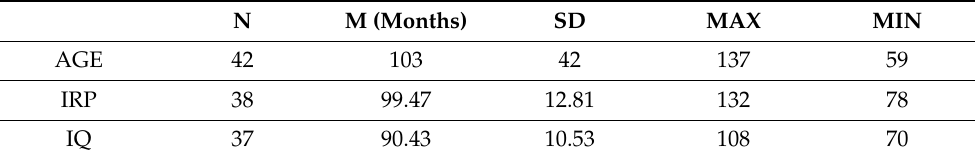
Table 1. Age, perceptual reasoning Index (IRP) and intellectual quotient (IQ) of the participants, based on numerosity (N), mean (M), standard deviation (SD), maximum value (MAX) and minimum value